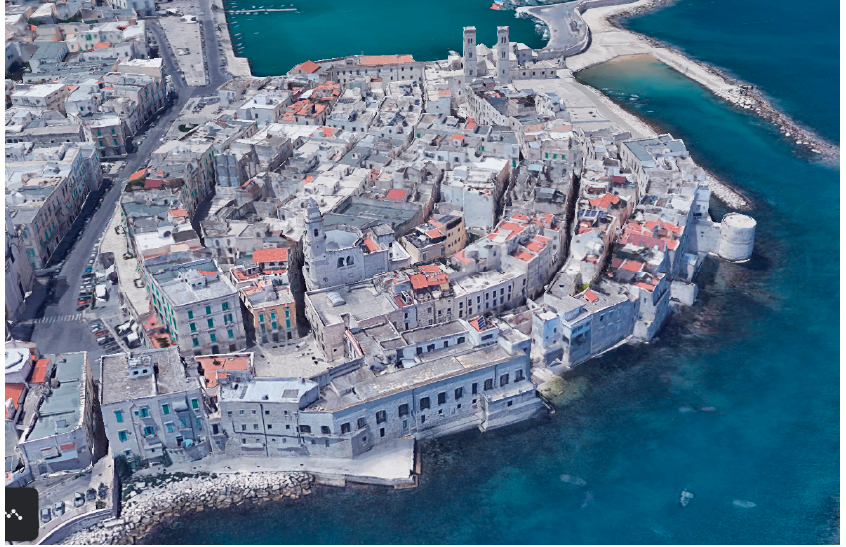
Figure 9. Aerial view of the old town.